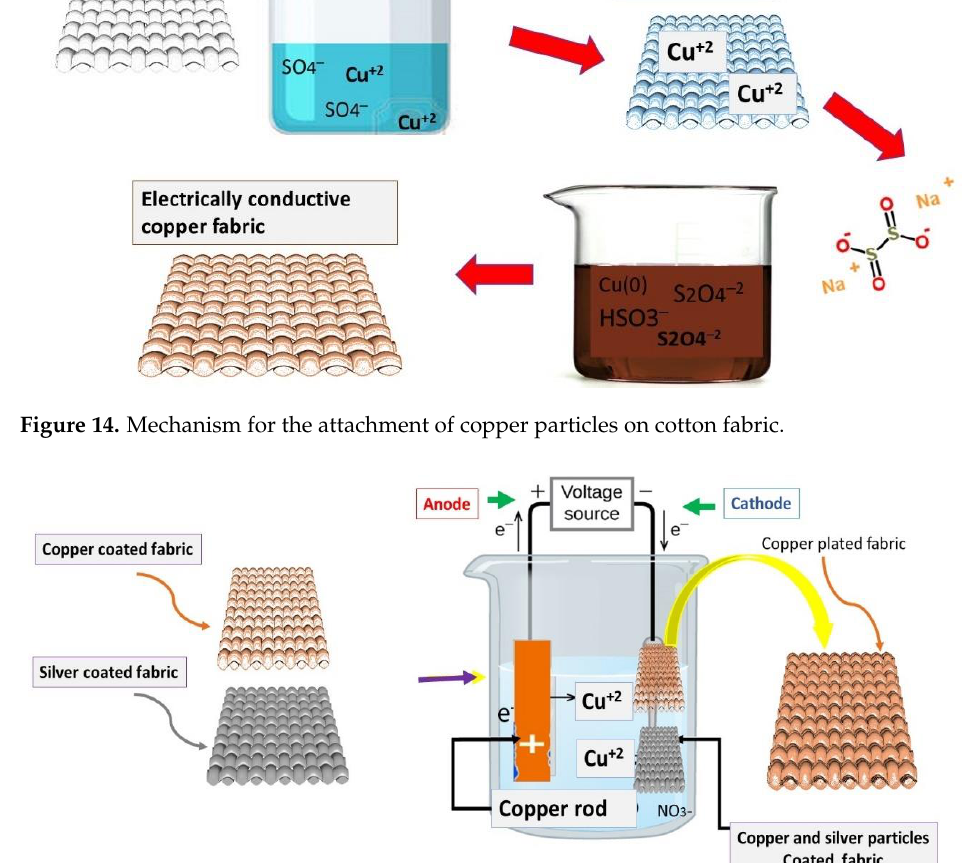
Figure 14. Mechanism for the attachment of copper particles on cotton fabric.